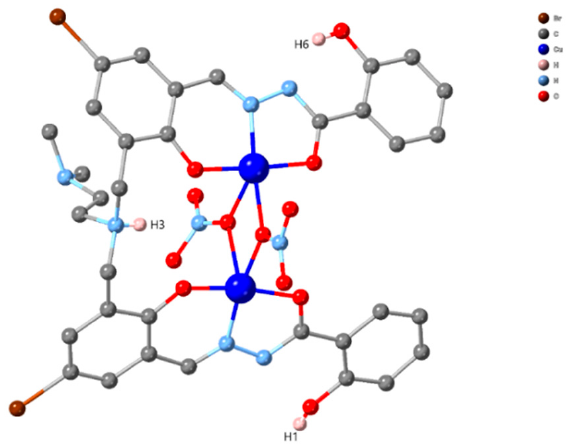
Figure 3. The crystallographically characterised pre-catalyst compound 9 .